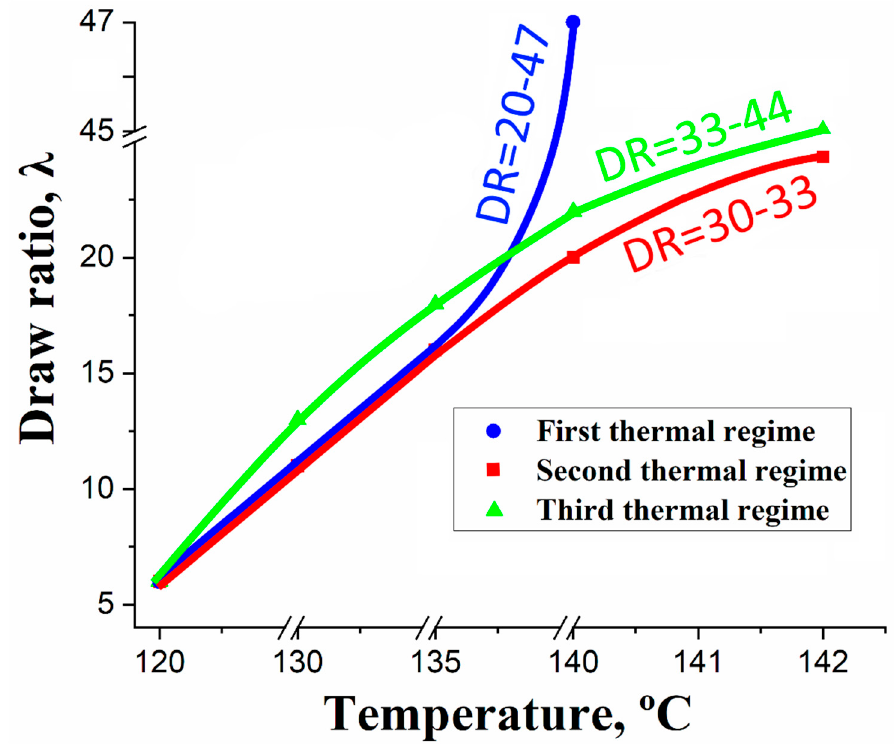
Figure 2. Thermal regimes and obtained draw ratio values in each stage of hot orientation process.